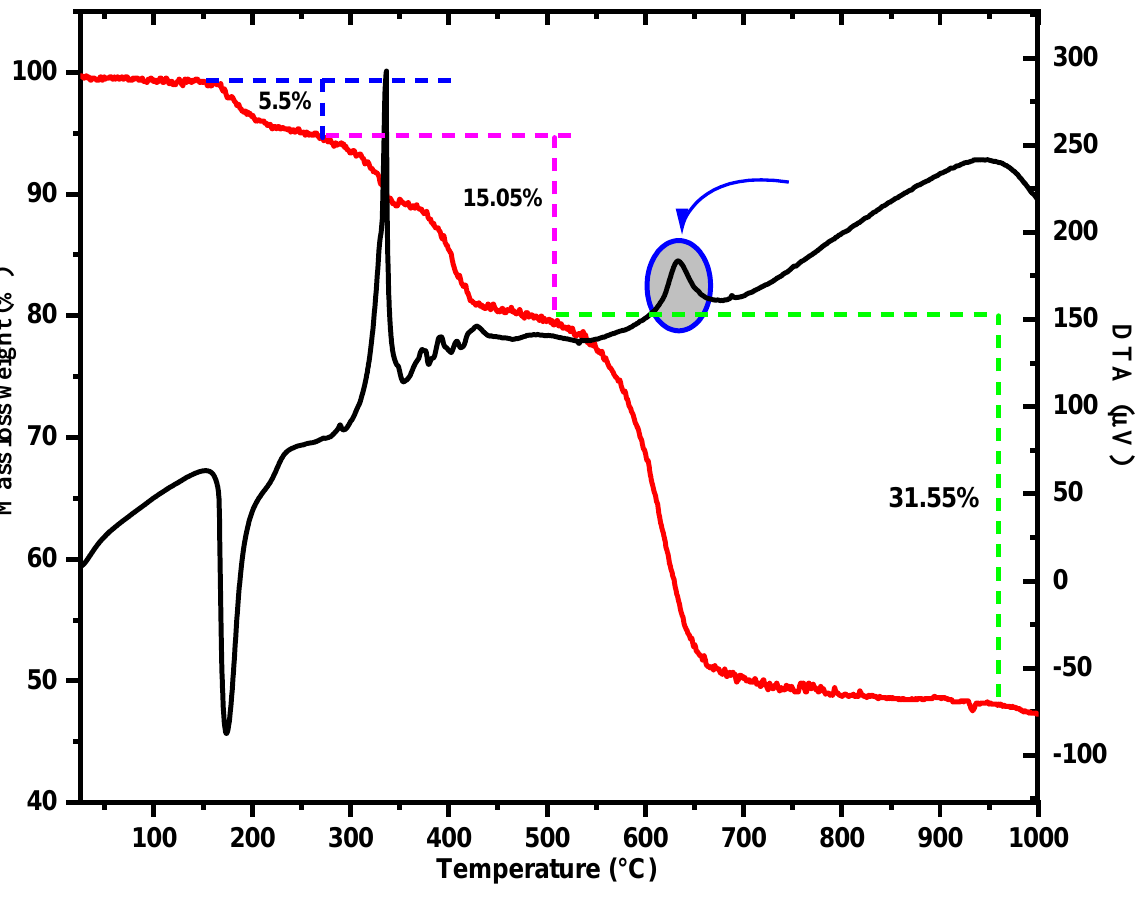
Figure 5. Thermogravimetric (TG) and differential thermal analysis (TDA) curves of (H 2 DAB)[Co(H 2 PO 3 ) 4 ]·2H 2 O.